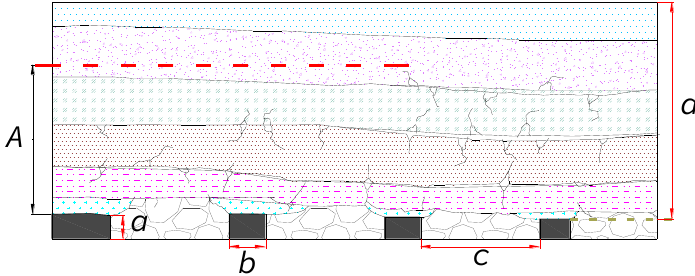
Figure 4. Illustration of the main controlling factors. A—HWFZ; a—Mining height; b—Width of the protection coal pillar; c—Length of block; d—Mining depth.